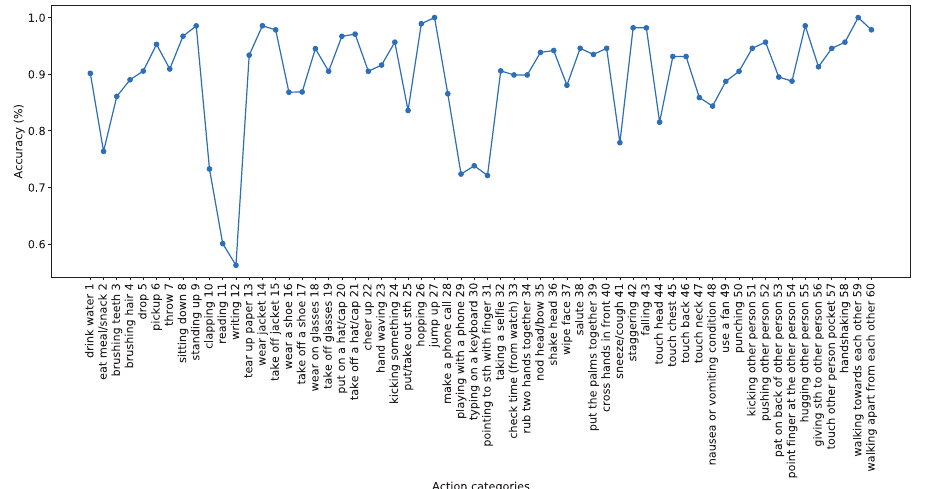
Figure 8. Results of accuracy comparison between each category on the NTU-RGB+D 60 X-Sub dataset; the horizontal and vertical axes denote the category and the accuracy,